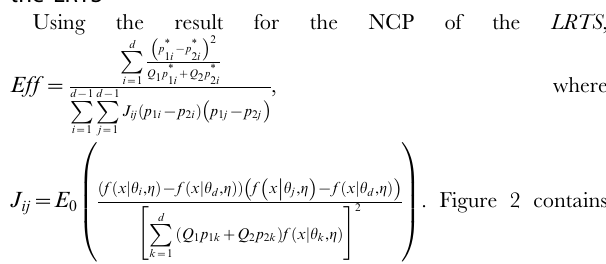
the relative efficiency of the 2 6 4 chi-square test with Bayesian rule classification with respect to the LRTS for the Extremes and Dosage models against the separation between successive category means.